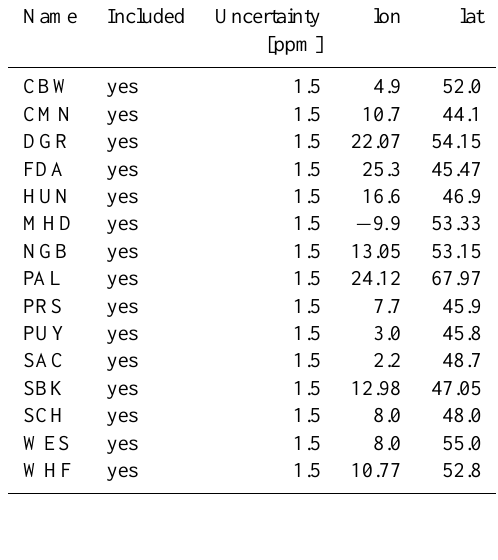
Table 3. Network flux . First number in site name indicates model grid cell and second number PFT.